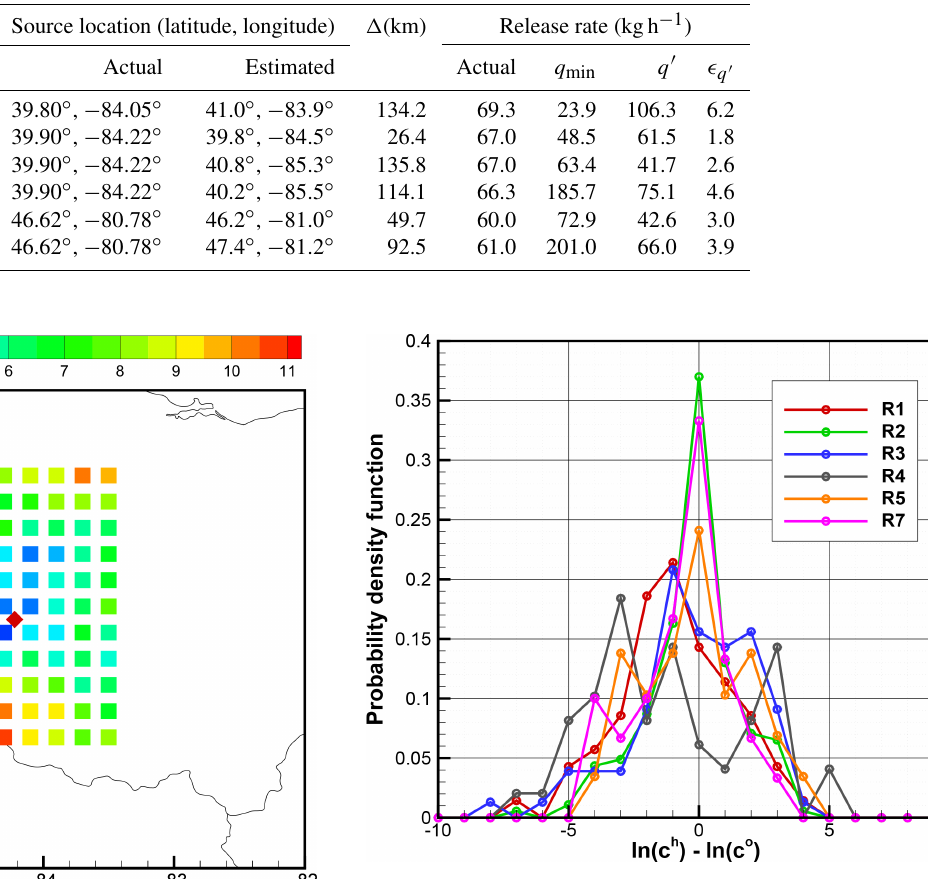
Figure 5. Probability density function (pdf) of ln (c h ) − ln (c o ) for the six CAPTEX releases. Units of c h and c o are pgm − 3 . The model prediction c h is calculated using the estimated release